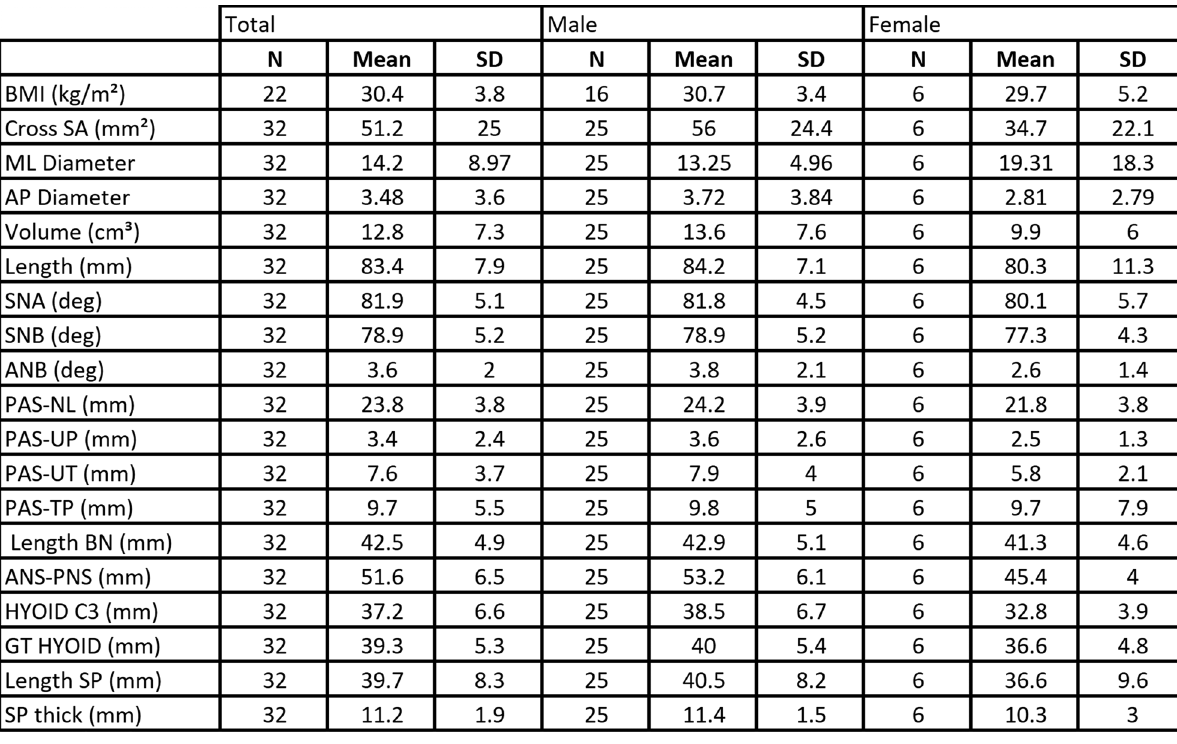
Table I. Descriptive